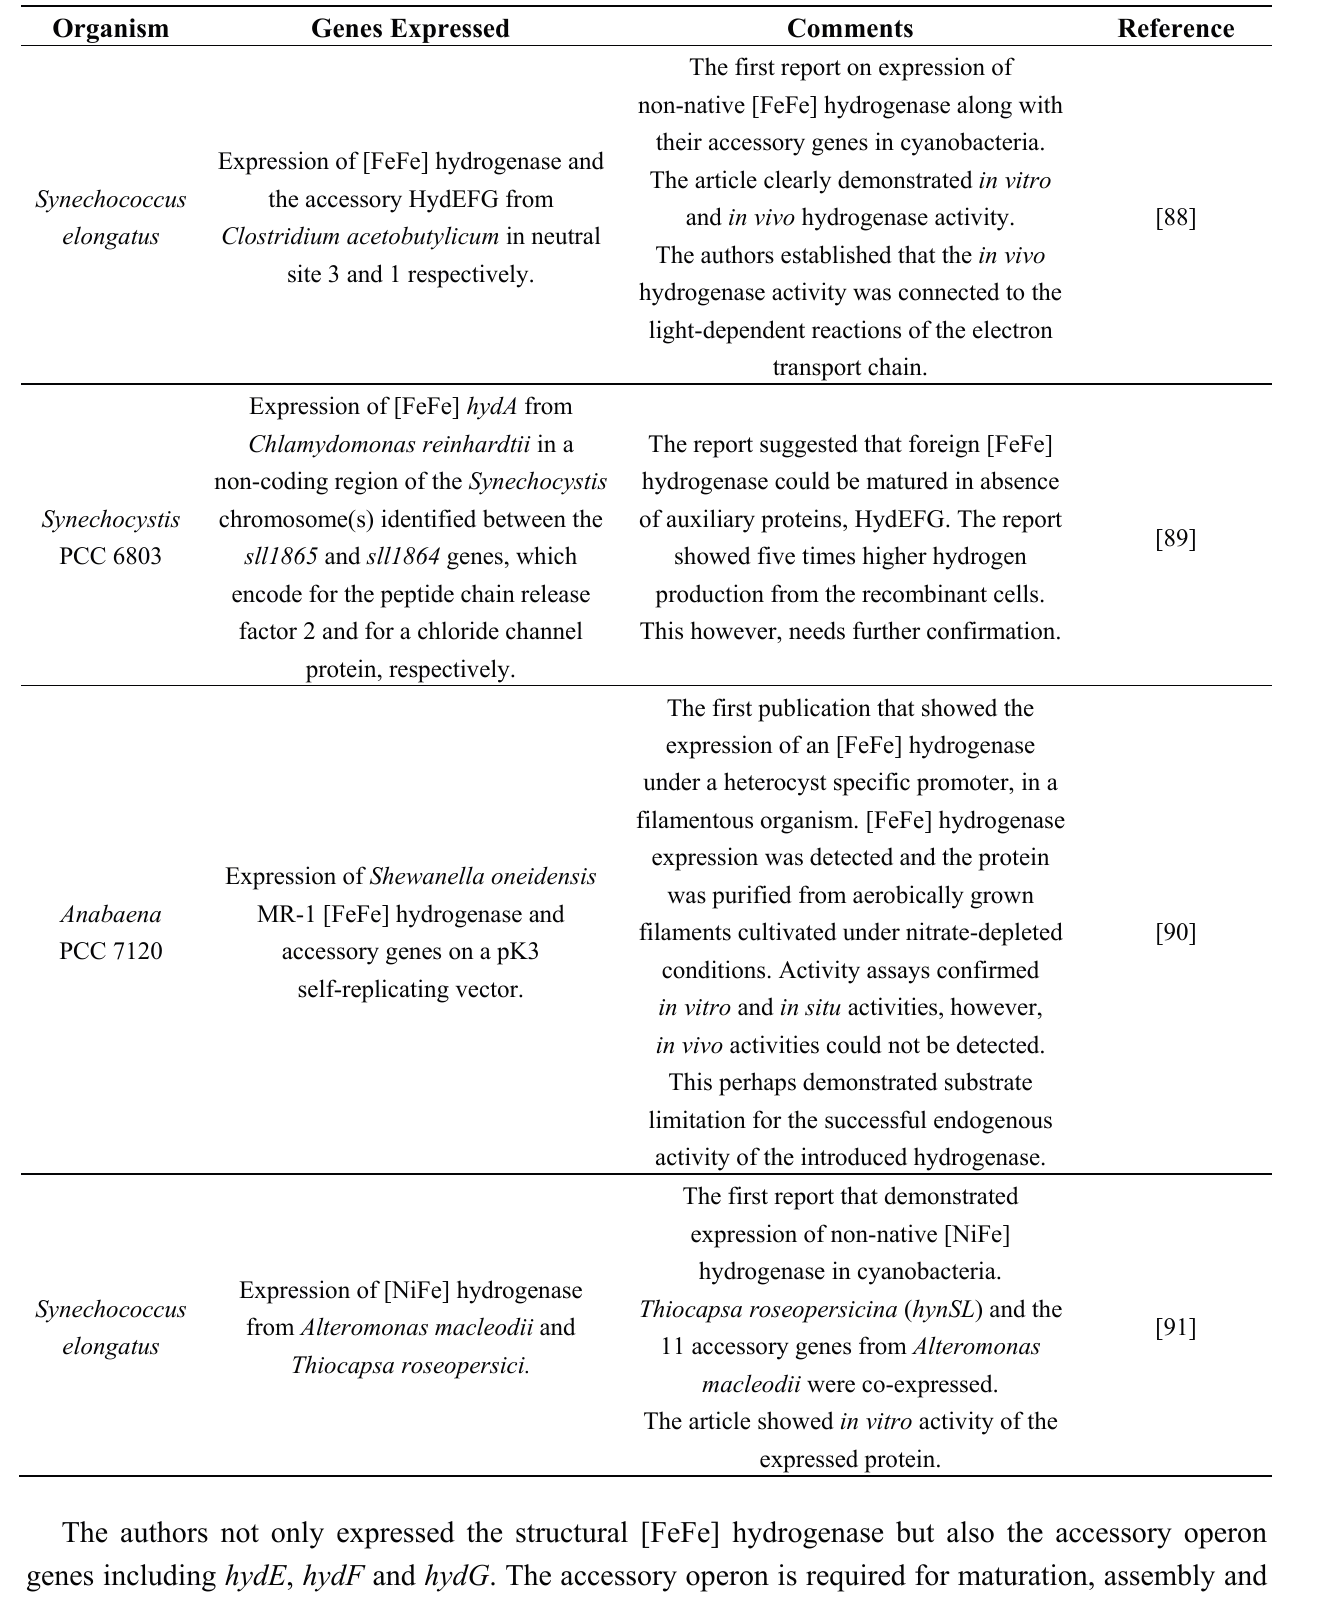
Table 1. Studies on the expression of non-native hydrogenase in cyanobacteria.